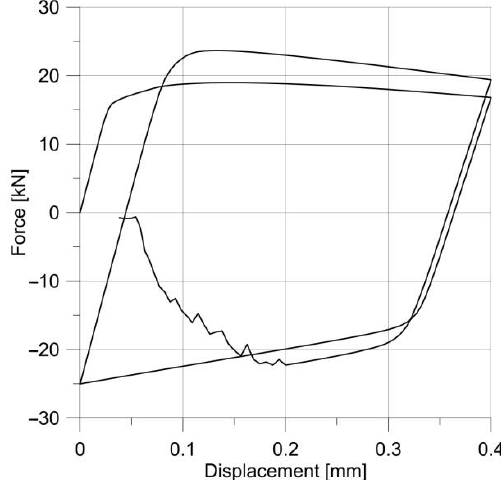
Figure 15. Changes in the stress – strain hysteresis loop for a specimen with a notch R = 2.5 mm.